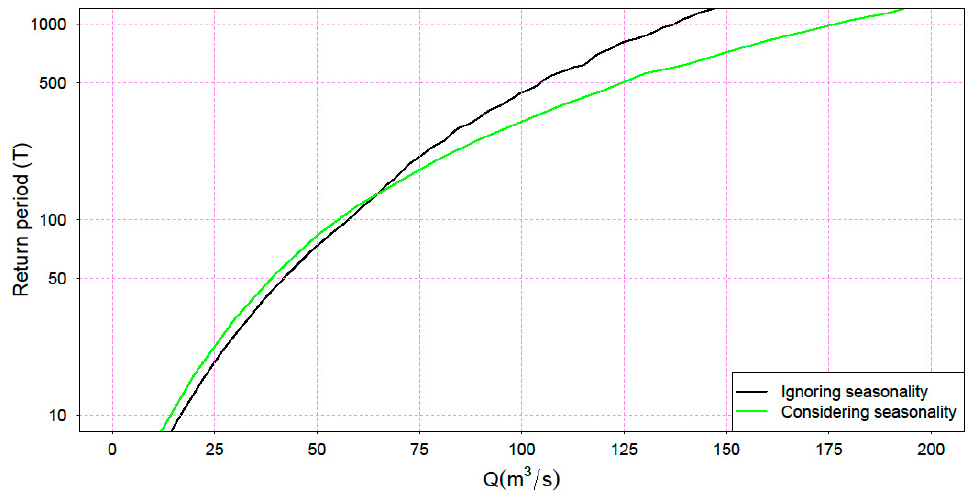
Figure 14. Plotting positions of MWRL derived from synthetic hydrograph dam routing.